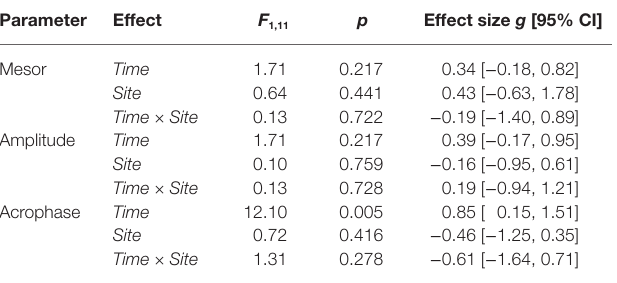
Two-way ANOVA was performed using Time (3rd week, 8th week) as a within-subject factor and Site (BBR2-2, Cocktail) as a between-subject factor. F, F-statistic; p, p-value. Effect size is Hedges’s g and their bootstrapped 95%